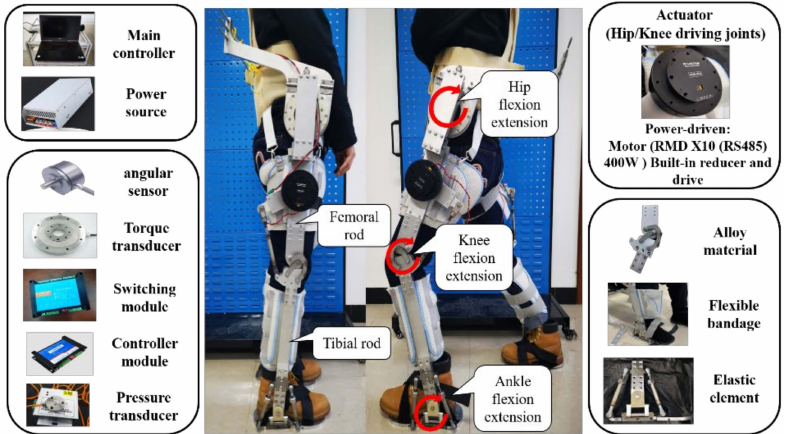
Figure 30. Accessories of lower-limb exoskeleton rehabilitation robot.